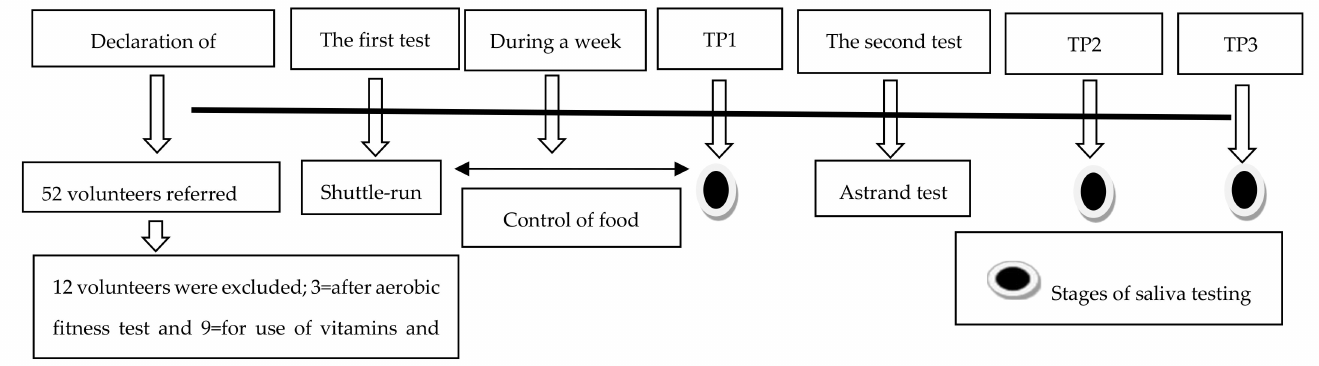
Figure 1. Diagram of the research outline. TP1 = time point from Pre-test, TP2 = time point immediately after the test, TP3 = time point one hour after the test.